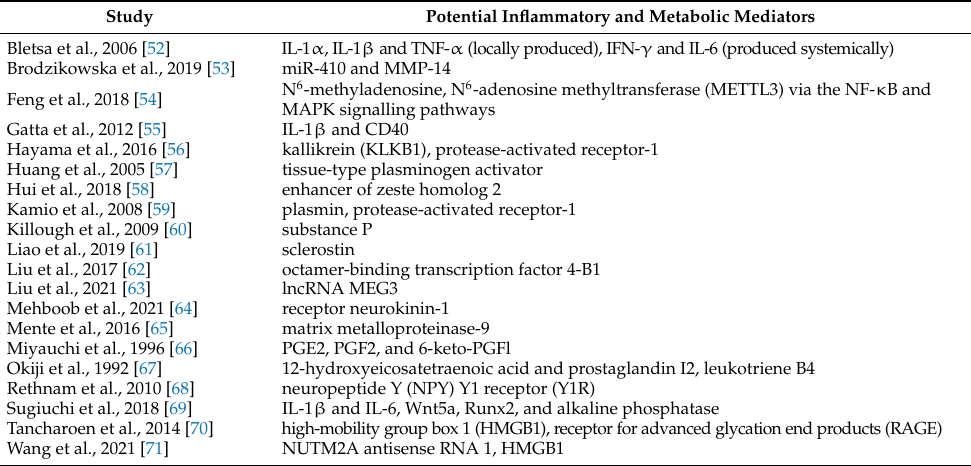
Table 1. Selected potential inflammatory and metabolic mediators during the pulp